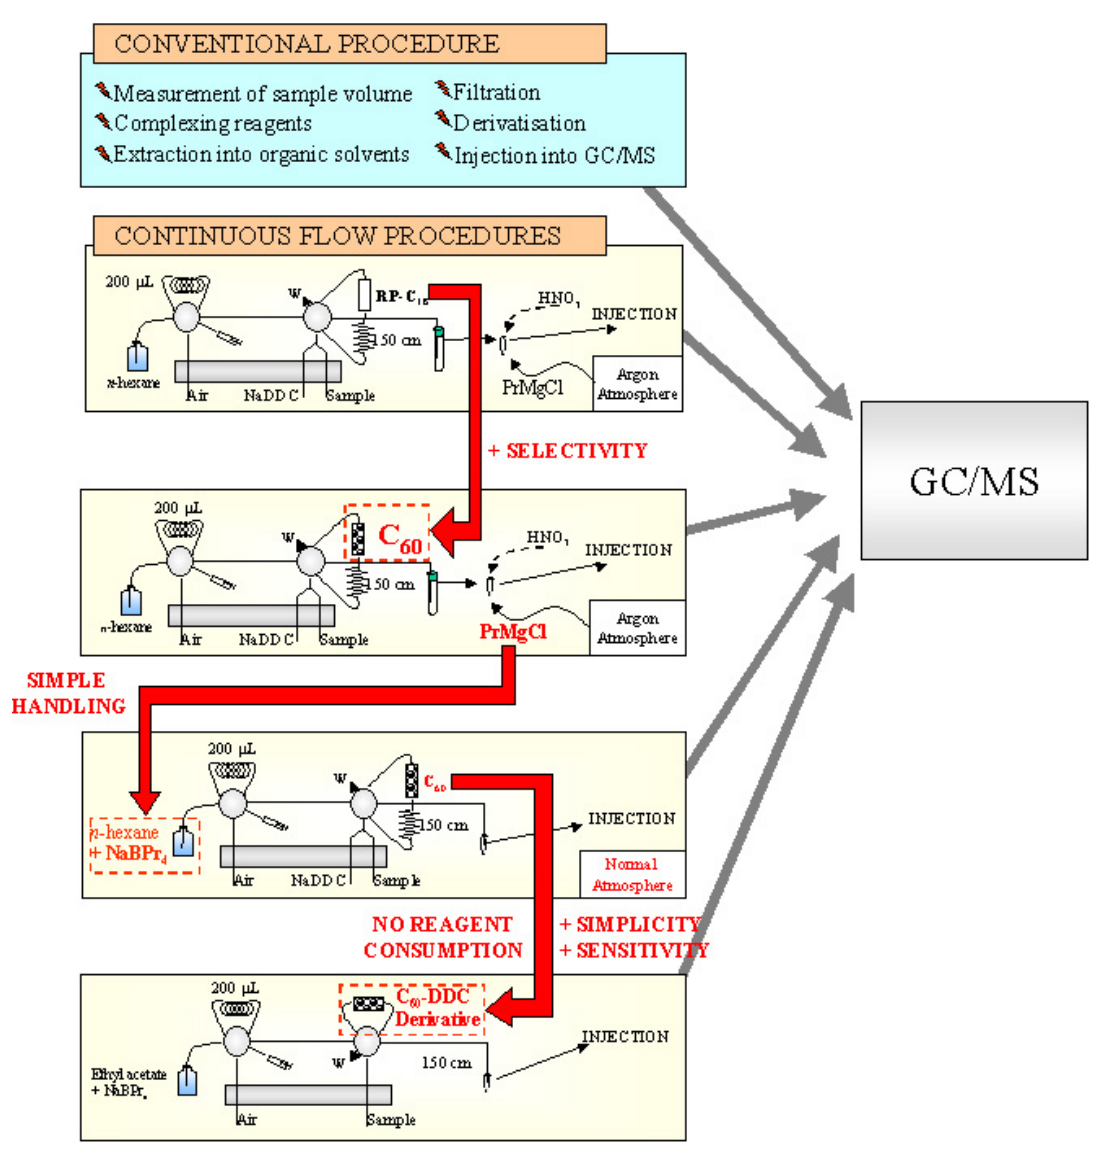
FIGURE 1. Evolution of the continuous-flow systems employed for the speciation analysis of organolead compounds in rainwater samples by GC/MS.